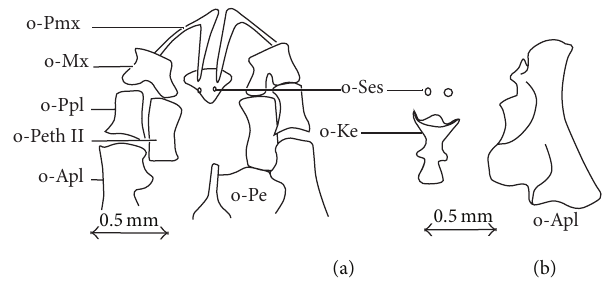
Figure2:(a)Anteriorpartoftheethmoidregionand(b)lateralplan of kinethmoid and autopalatine of Oxynoemacheilus chomanicus